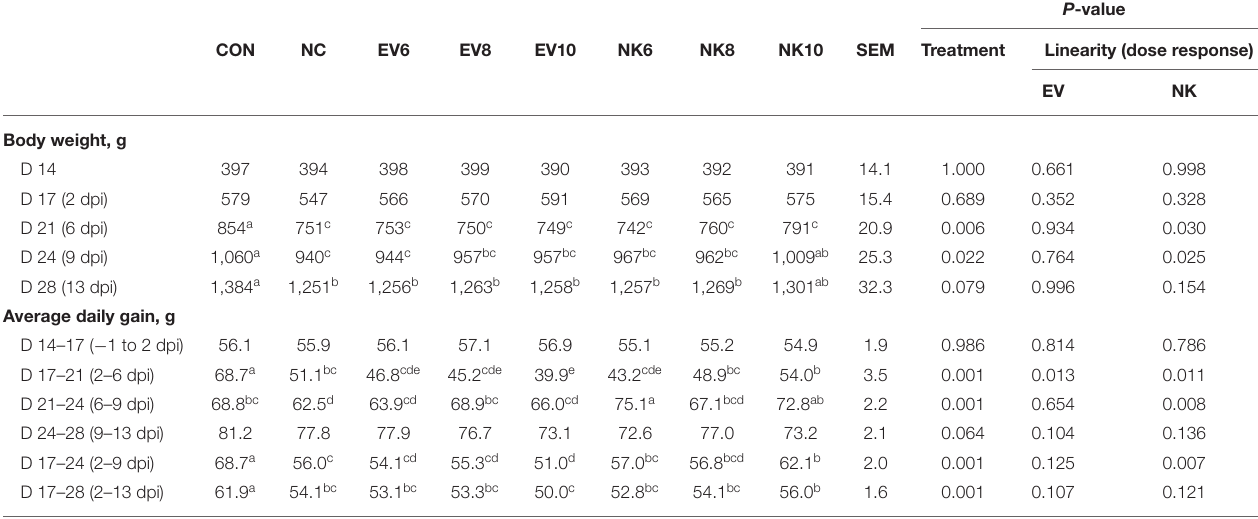
TABLE 3 | Body weights of Eimeria acervulina -infected chickens following treatment with Bacillus subtilis expressing cNK-2. CON NC EV6 SEM Treatment Linearity (dose response)